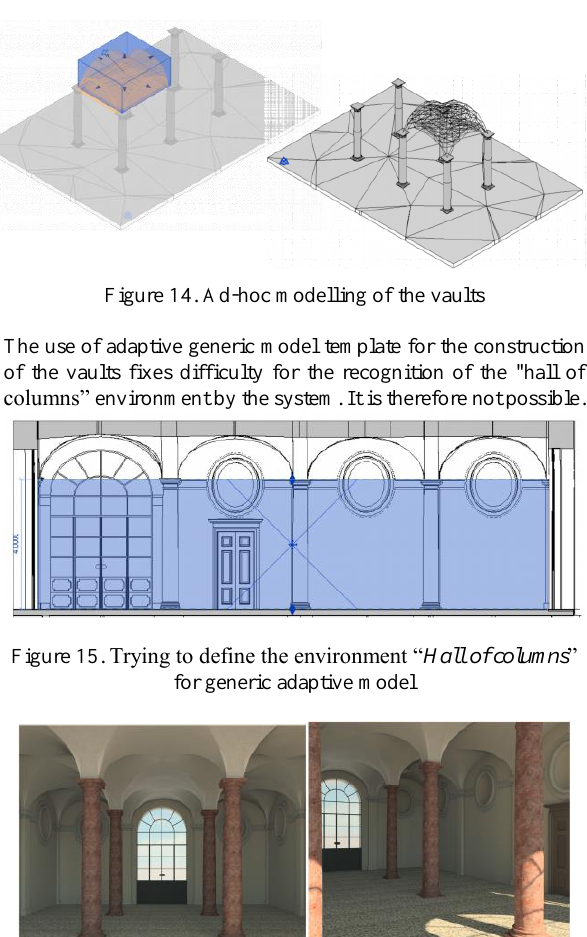
Figure 13. Modelling of the column by parametrization